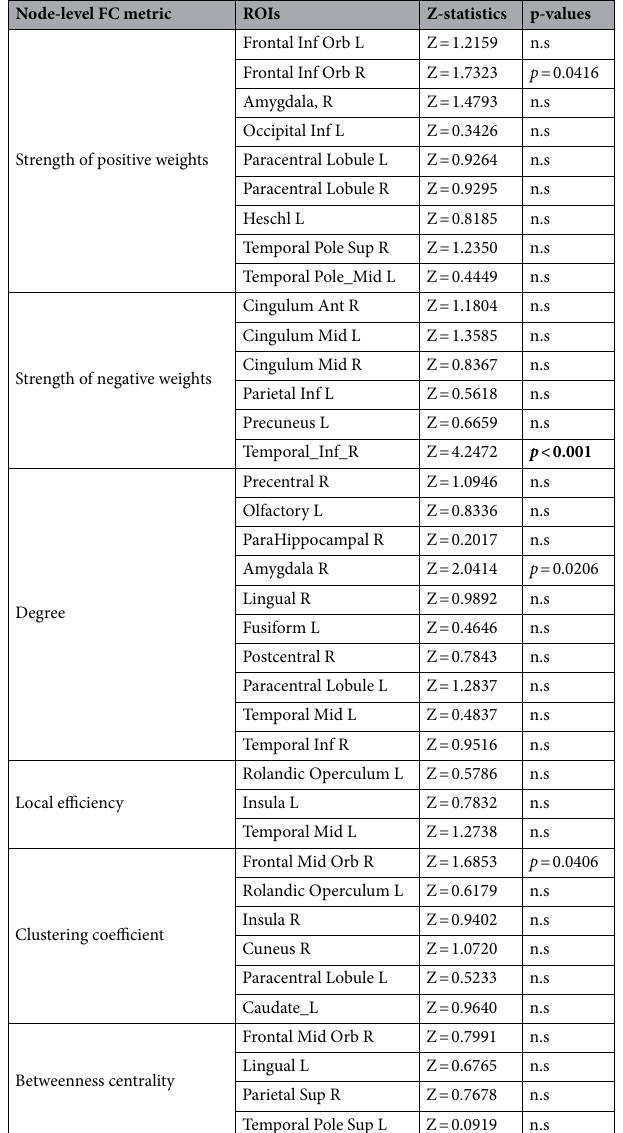
Table 2. Location and statistics of epistatic effects on node-level FC metrics, reported for each ROI that result significantly and non-significantly influenced by epistatic effect. Orb, orbital part; Inf, inferior part; Mid, middle or median part; Sup, superior part, R, right; L, left; Post, posterior part; Ant, anterior part; FC, functional connectivity; Z: Fisher’s Z statistics; n.s., not significant. P-values surviving the Bonferroni correction are